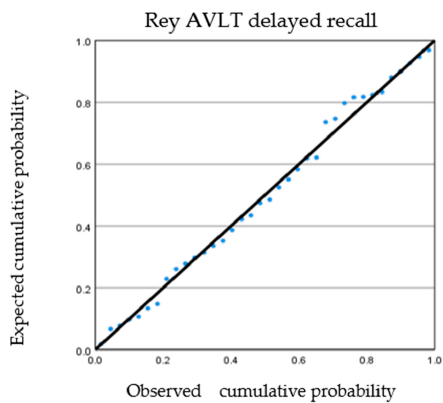
Figure 1. Regression plot of standardized residues for variable AVLT delayed recall.